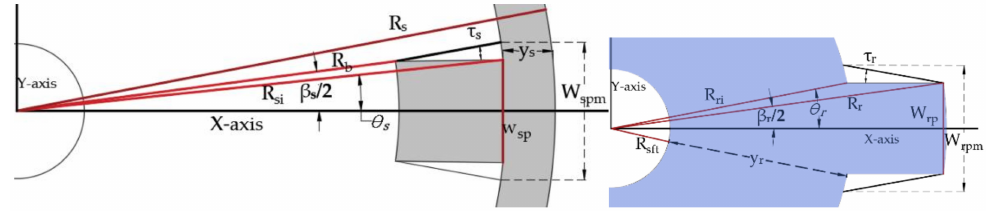
Figure 5. Detailed notations of stator and rotor poles.